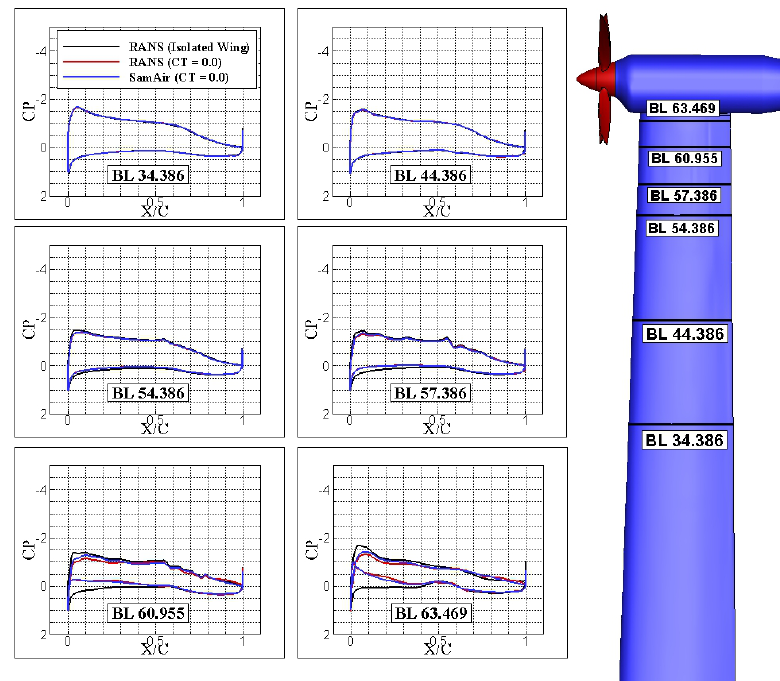
Figure 11. Surfaces pressure data of propeller-off predictions at α = 5 ◦ .